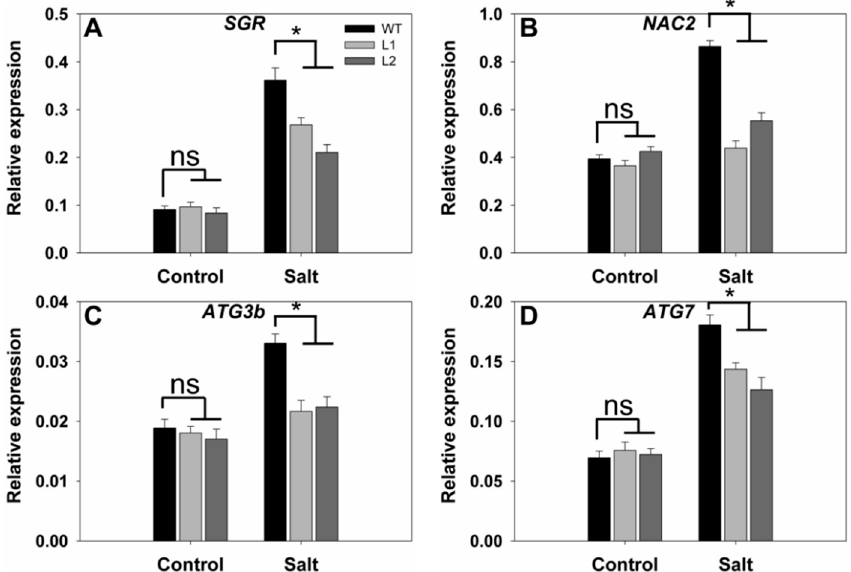
Figure 8. Expression levels in response to salinity stress of senescence- and autophagy-related genes in SS3p:SS3 transgenic lines compared with WT. Growth conditions and treatments were as described in Figure 7. RNA was extracted from the leaf blades and qRT-PCR was used to detect transcript levels of OsSGR ( A ), OsNAC2 ( B ), OsATG3b ( C ), and OsATG7 ( D ). The values are means ± SE of three replicates. Significant differences between WT and transgenic lines at p < 0.05 are indicated with asterisks; ns indicates non-significant differences.